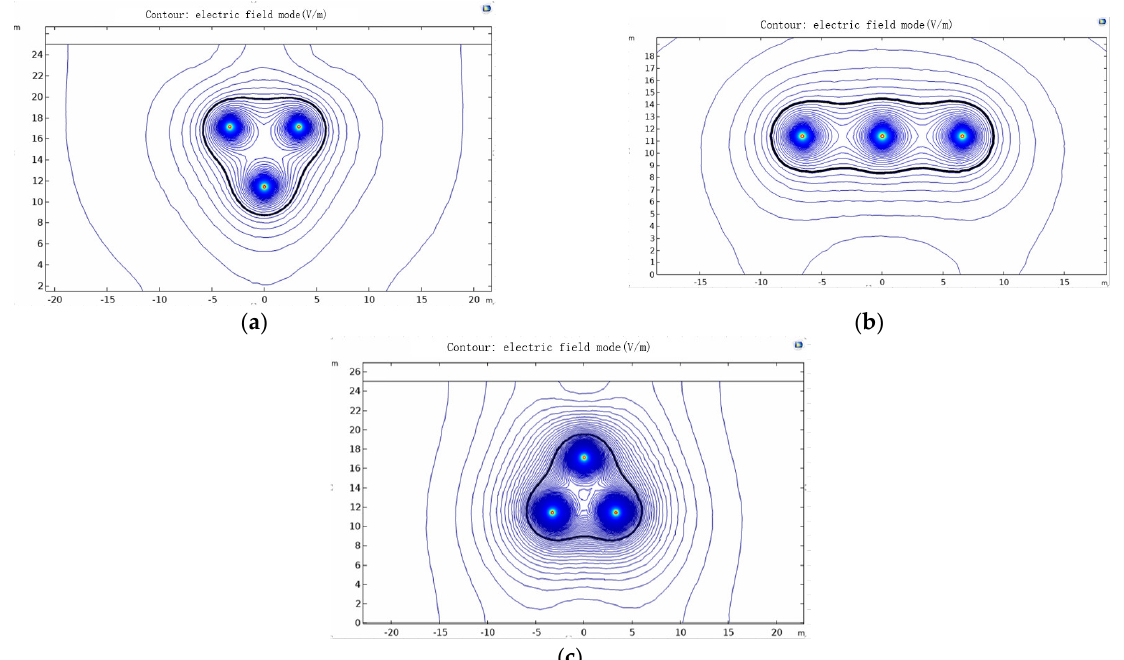
Figure 5. Electric field distribution around transmission lines with different arrangement of 220 kV voltage levels. ( a ) Field strength distribution under 220 kV inverted triangle arrangement; ( b ) field strength distribution under 220 kV horizontal arrangement; ( c ) field strength distribution of 220 kV regular triangle.